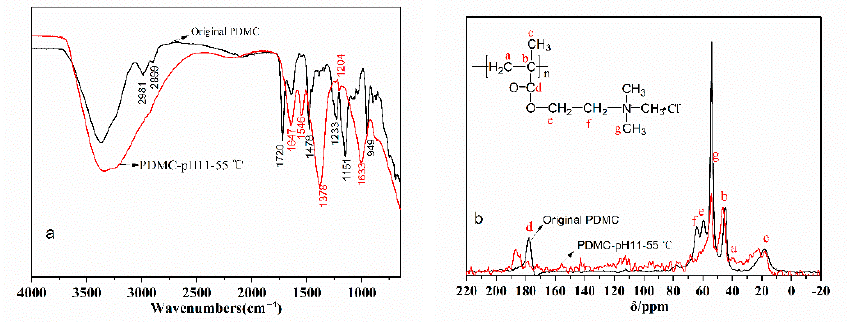
Figure 17. Infrared ( a ) and 13 CNMR ( b ) spectra of original and hydrolyzed PDMC polymer.